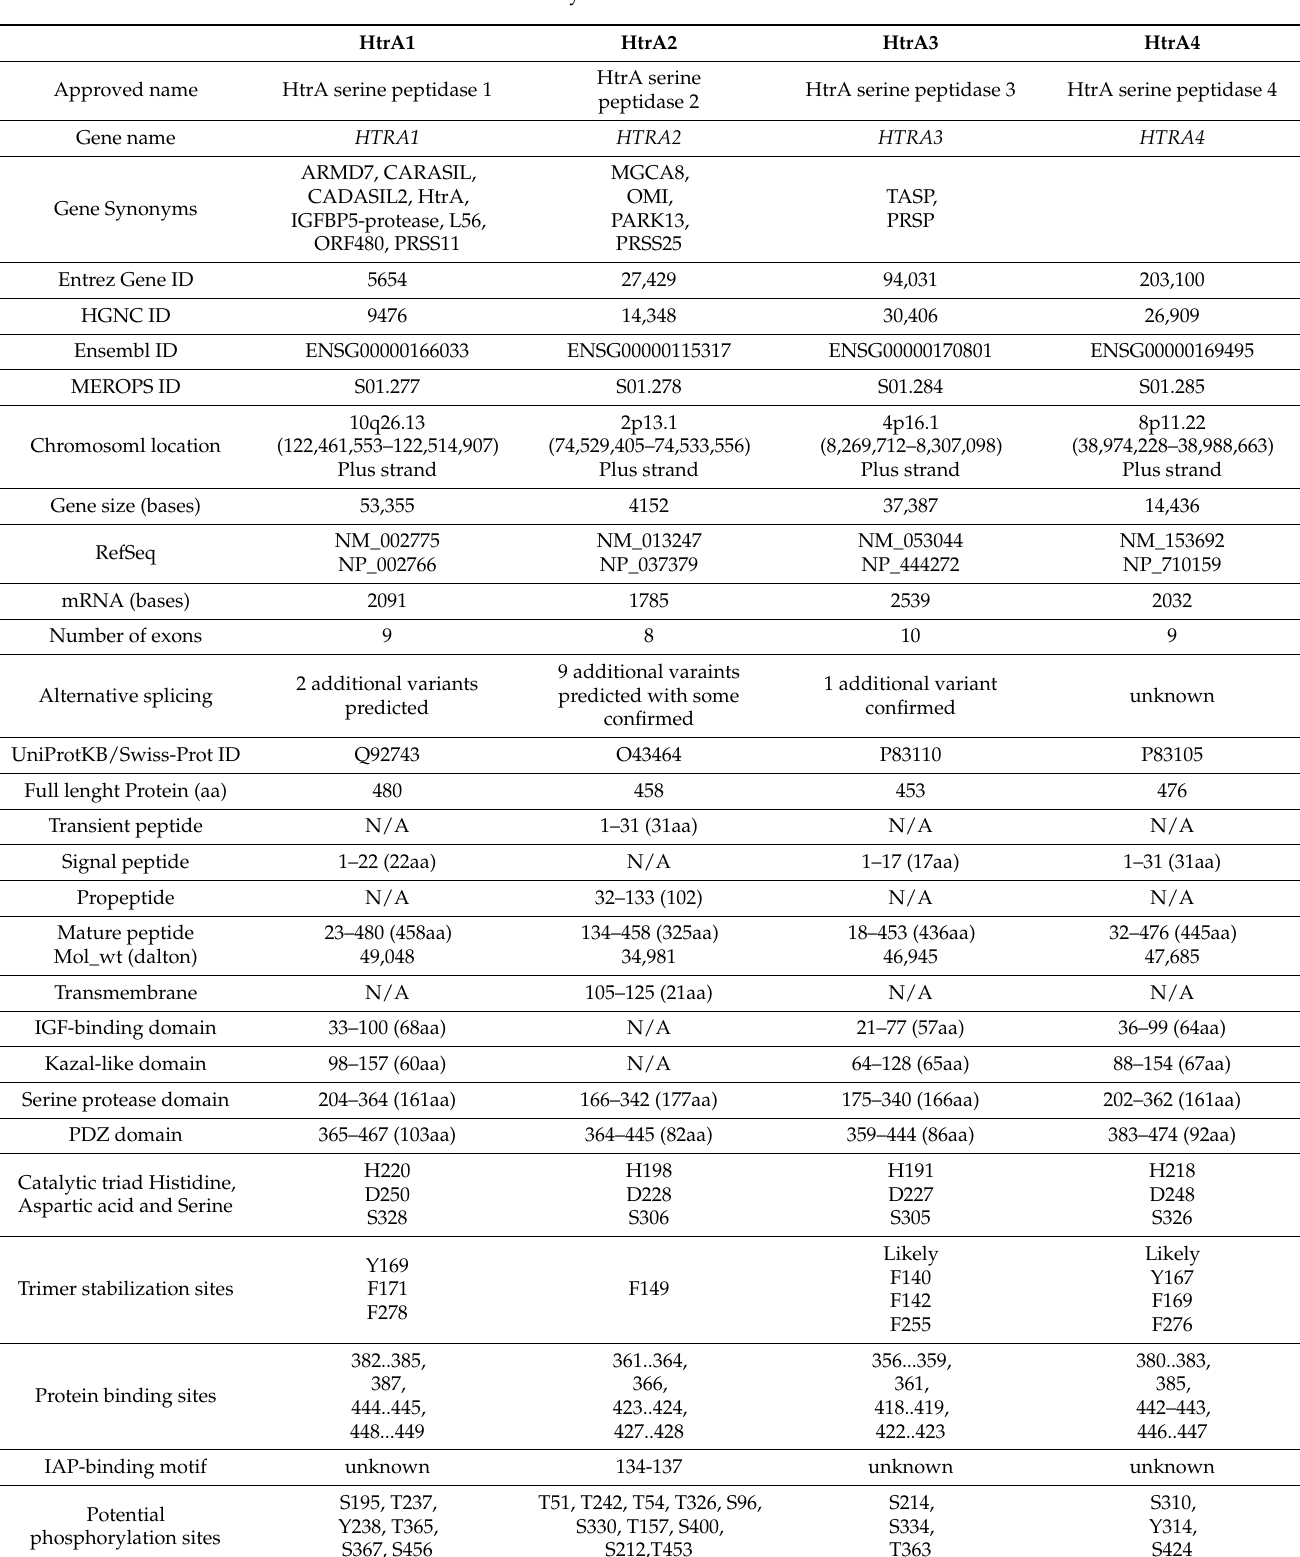
Table 1. Key features of human